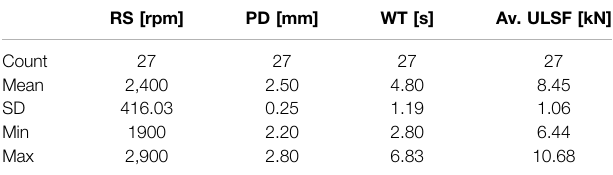
TABLE 2 | Statistical description of the data.